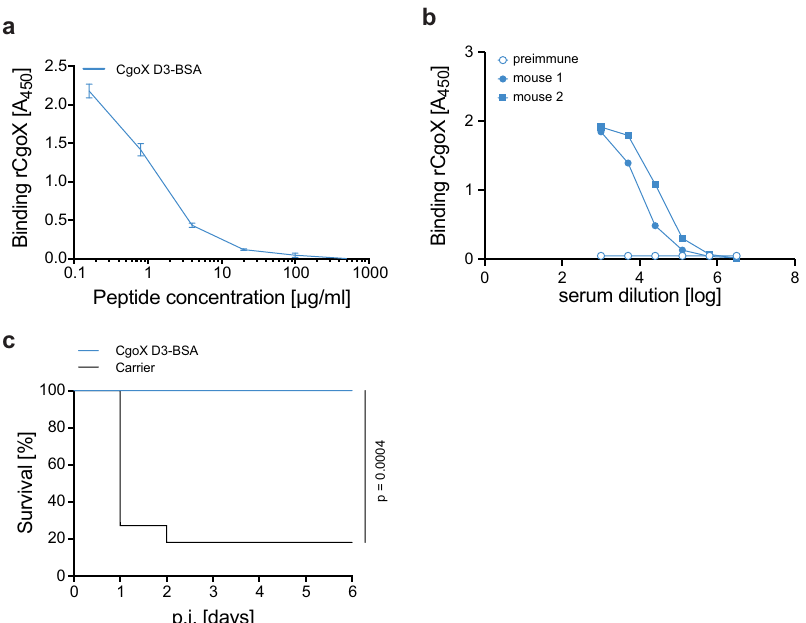
Fig. 5 Active immunisation with anti-CgoX mAb D3 epitope peptide. a Competition ELISA. Binding of anti-CgoX mAb D3 to rCgoX coated on ELISA MaxiSorp plate was competed for with CgoX-D3-BSA conjugate. Binding was detected with anti-mIgG-HRP and compared to control sample (BSA). b Anti-CgoX-BSA IgG titer. Sera of two CgoX-D3-BSA immunised mice were collected at day 68 and analysed together with preimmune serum for anti-CgoX IgGs by ELISA. c Survival of mice challenged with S. aureus upon immunisation with CgoX-D3 epitope peptide conjugated with BSA. BALB/c mice ( n = 11) immunised with CgoX-D3-BSA or the carrier protein BSA (black) as control group ( n = 10), were infected i.p. with 3.3 × 10 7 cfu S. aureus USA300 mixed with 5% mucin from porcine stomach. Signi fi cance was calculated by Log-rank (Mantel-Cox)